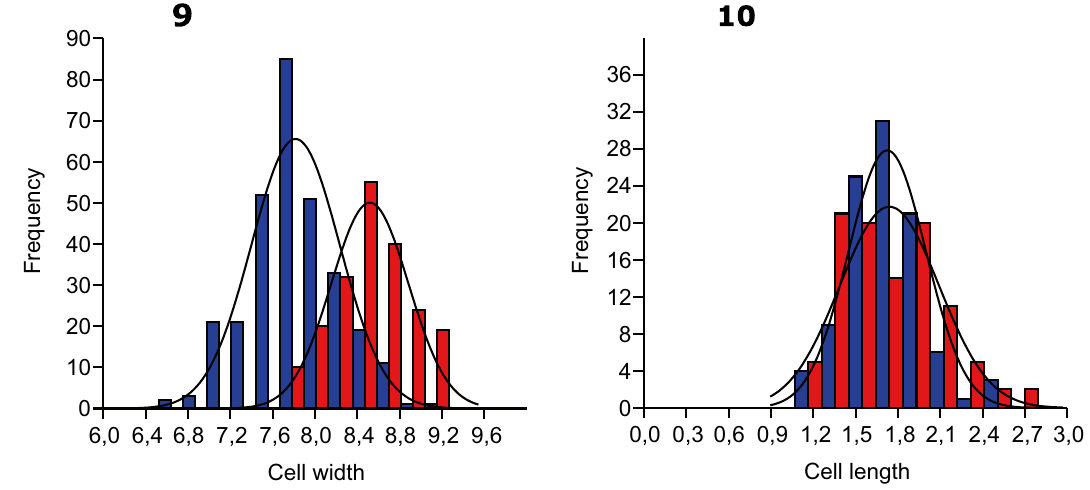
Figures 9 and 10. Histograms of cell dimensions constructed using PAST software. Fig. 9 – Histogram of cell width frequencies in A. galeatum (blue) and A. antarcticum (red). Fig. 10 – Histogram of cell length frequencies in A. galeatum (blue) and A. antarcticum (red).